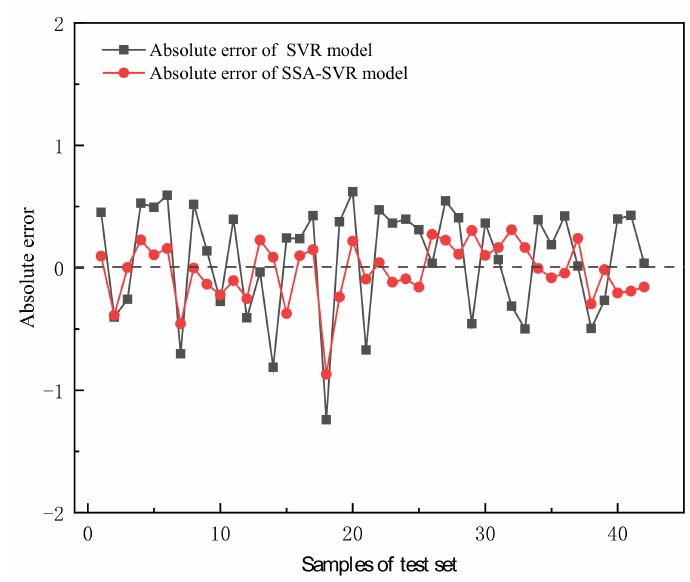
Figure 17. Absolute errors of SVR and SSA-SVR